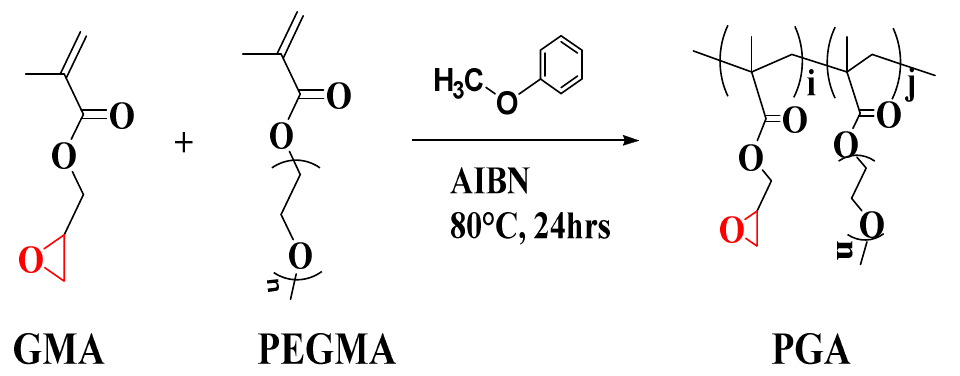
3 of 14 Figure 1. Three types of SPEs: ( 1 ) slightly crosslinked SPE based on ED2003, ( 2 ) tightly crosslinked SPE based on hyper- branched PEI, ( 3 ) an interlocking bilayer structure of SPE. 2. Experimental 2.1. Materials Linear curing agent Jeffaimne ED2003 was obtained from Huntsman corporation (Woodlands, TX, U.S). Poly(ethylene glycol) methyl ether methacrylate (PEGMA, M n = 500) monomer, glycidyl methacrylate (GMA, 97%) monomer, hyperbranched polyeth- yleneimine (PEI, Mn = 800), and lithium salt of bis(trifluoromethane)sulfonimide lithium salt (LiTFSI) were purchased from Sigma-Aldrich and used as received. Poly(ethylene ox- ide) (PEO) (M.W = 600,000~1,000,000) was provided by Acros (Geel, Belgium). Azobisiso- butyronitrile (AIBN) initiator was purchased from Aencore (Melbourne, Australia). Ani- sole and acetonitrile (ACN) were used without further purification. Cathode material, lithium iron phosphate (LiFePO 4 ; LFP), and lithium (Li) metal for the anode for lithium ion batteries (LIBs) were obtained from UBIQ Technology Corp. (Taipei, Taiwan), which were stored under vacuum to avoid humidity. 2.2. Preparation of Epoxy Containing Copolymer The synthetic route for PGA copolymer is shown in Scheme 1. A mixture of GMA (2.843 g, 0.02 mol) and PEGMA (10 g, 0.02 mol) in 30 mL anisole was added into a three- neck bottom flask, followed by adding AIBN (0.433 g, 0.0002 mol) as the initiator. The solution was stirred at 80 °C for 24 h under nitrogen atmosphere. After the reaction,